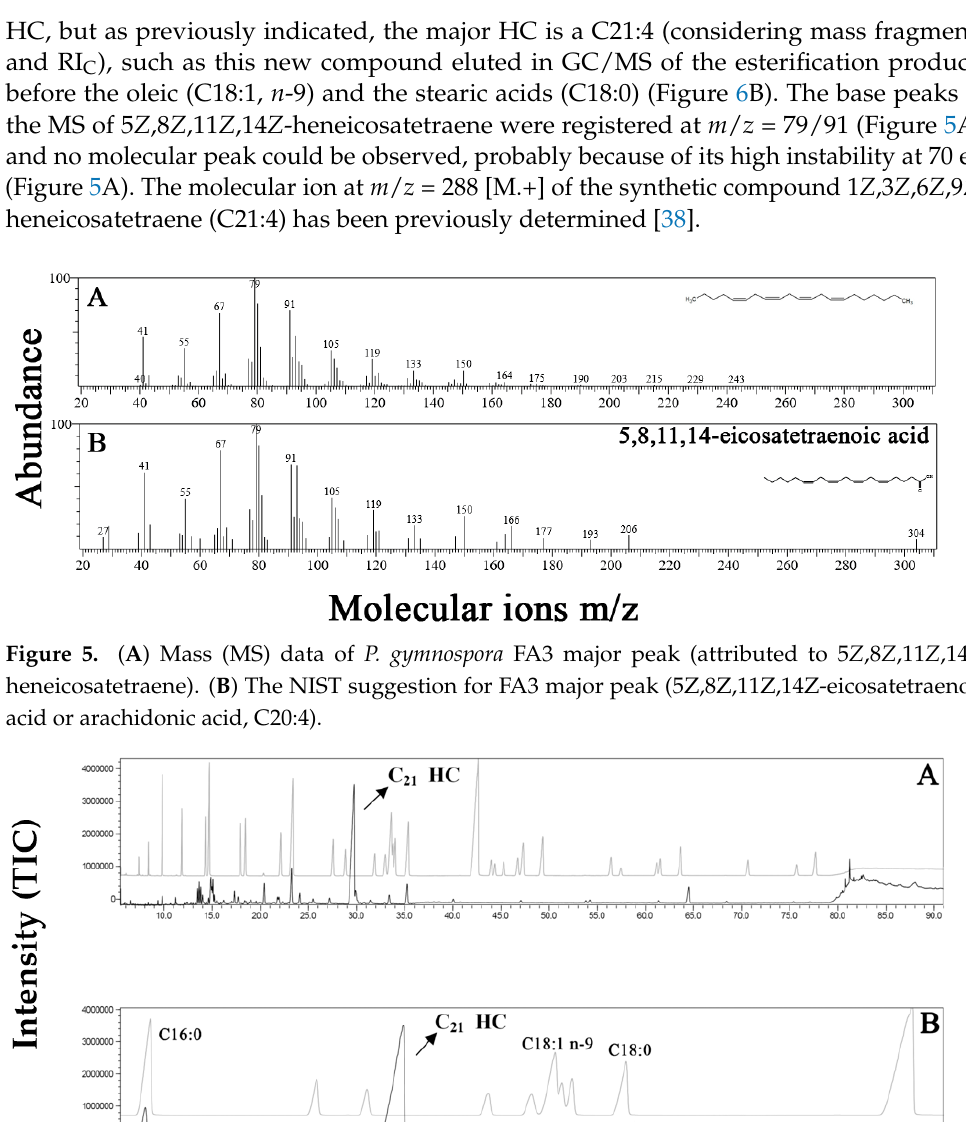
Table 1. Gas chromatography coupled to Mass Spectrometry (GC/MS) analysis of fatty acids (FAs) and hydrocarbons (HC) from P. gymnospora in the fraction FA3. RI = Retention index. The FAs iden- tification was made comparing the mass spectrum of FAME FAs and the calculated Retention Index